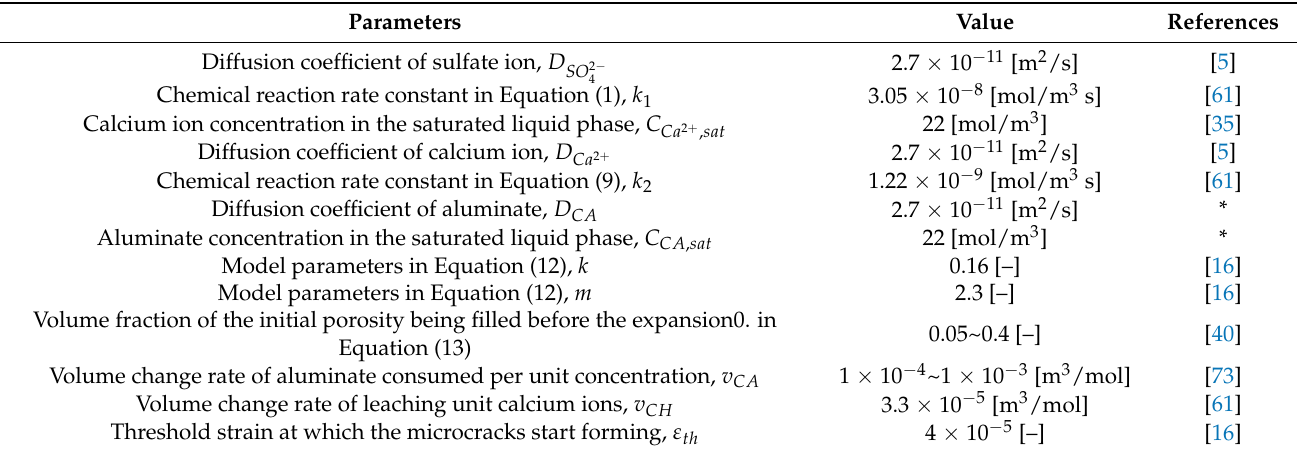
Table 1. Main parameters in the proposed sulfate attack model.